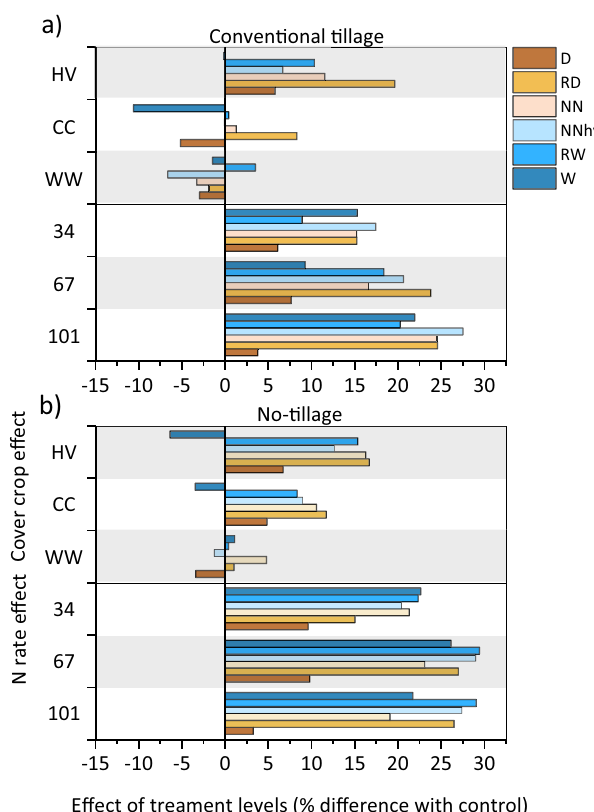
Fig. 5 Yield bene fi ts of N rates and cover crops compared with associated control treatments (0 N rate and no cover crop). Values are reported across dry (D), relatively dry (RD), near-normal (NN), high- yielding near-normal (NNhy), relatively wet (RW), and wet (W) climate conditions under a conventional tillage and b